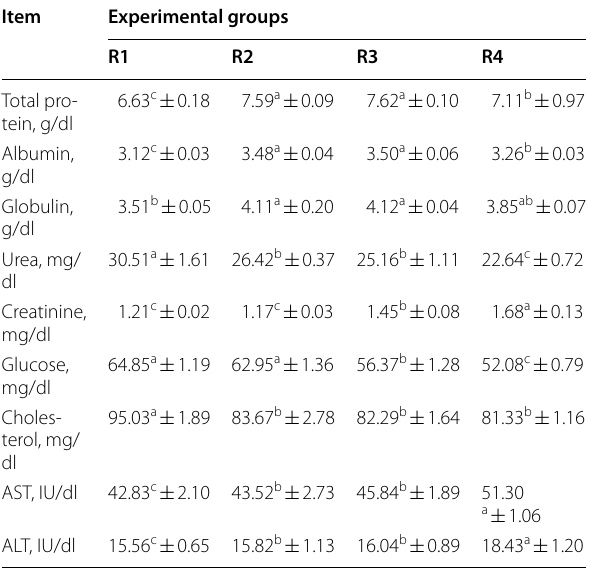
a,b,c Means within rows followed by different superscripts are significantly different at ( P < 0.05)